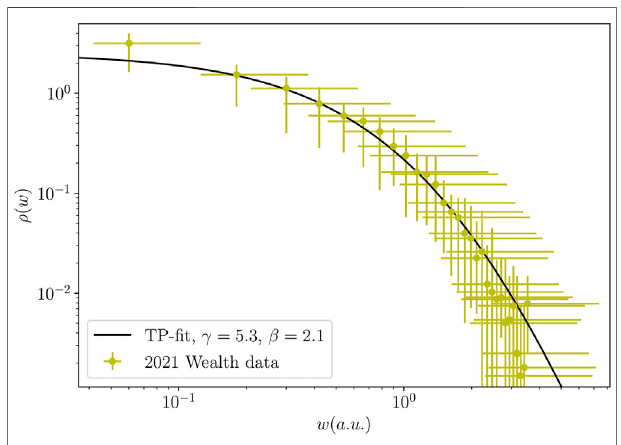
FIGURE 4 | Probability density for wealth distribution in 2021. Error bars are obtained by combining the results of the different weight parameter sets shownin Table5 .Wealthvaluesaregiveninarbitraryunits(a.u.)asitisargued in Section 2.2 . The theoretical distribution (11) fi tted to the averaged experimental distribution ( γ = 5.3 and β =2.1) is shown bythe continuous line. Please note the logarithmic scales.